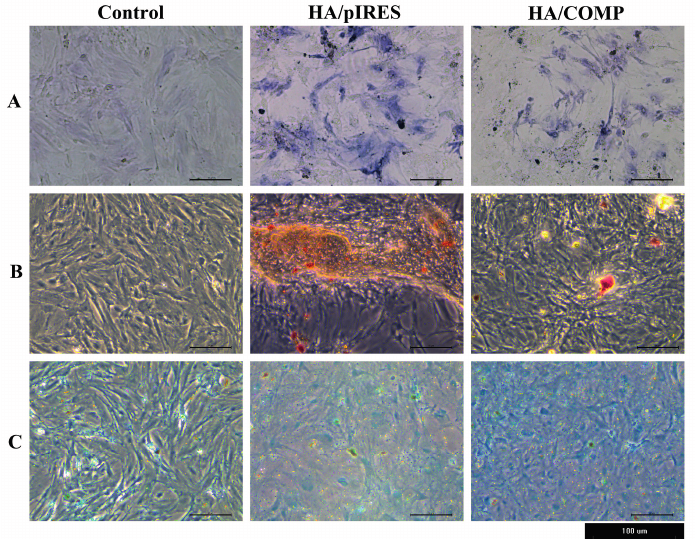
Figure 9. Cell staining of mesenchymal stem cells (MSCs) cultured with TCPs, HA/pIRES films and HA/COMP films. ( A ) alkaline phosphatase (ALP) staining of MSCs after osteogenic induction for 7 days; ( B ) Alizarin red S staining of MSCs after osteogenic induction for 14 days; ( C ) Alcian blue staining of MSCs after chondrogenic induction for 21